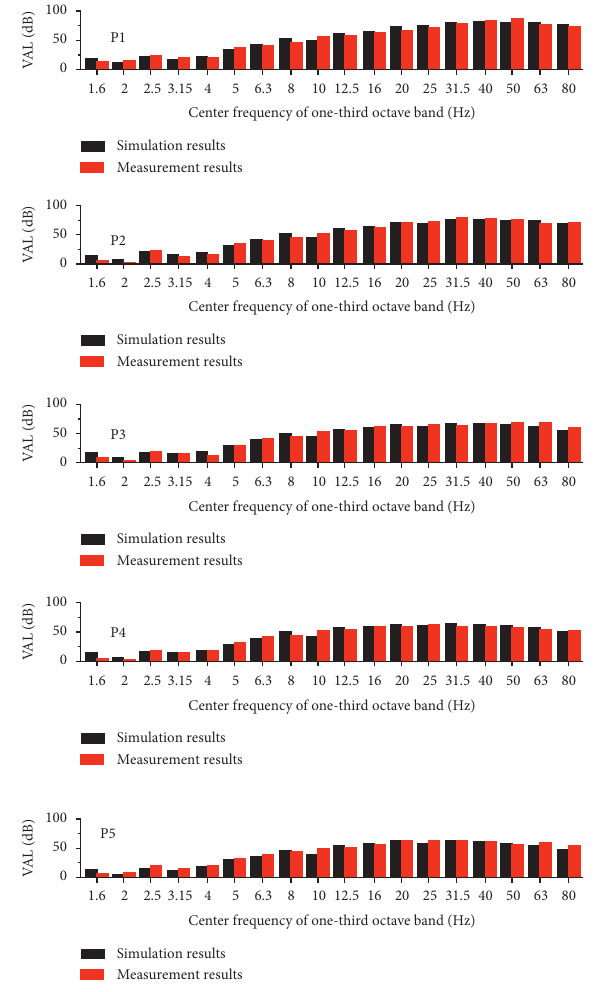
Figure 5: Comparison of calculated vibration acceleration levels to the measured